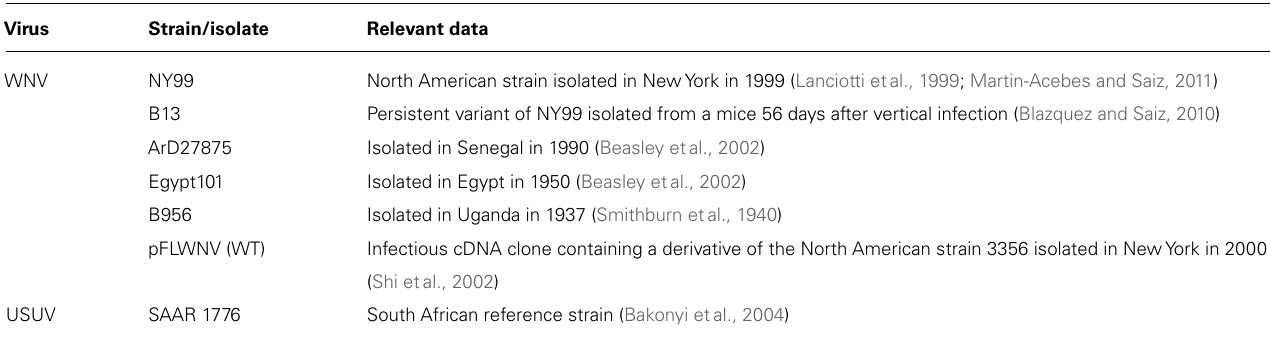
Table 1 |Virus strains, isolates and infectious cDNA clone used in the study. Virus